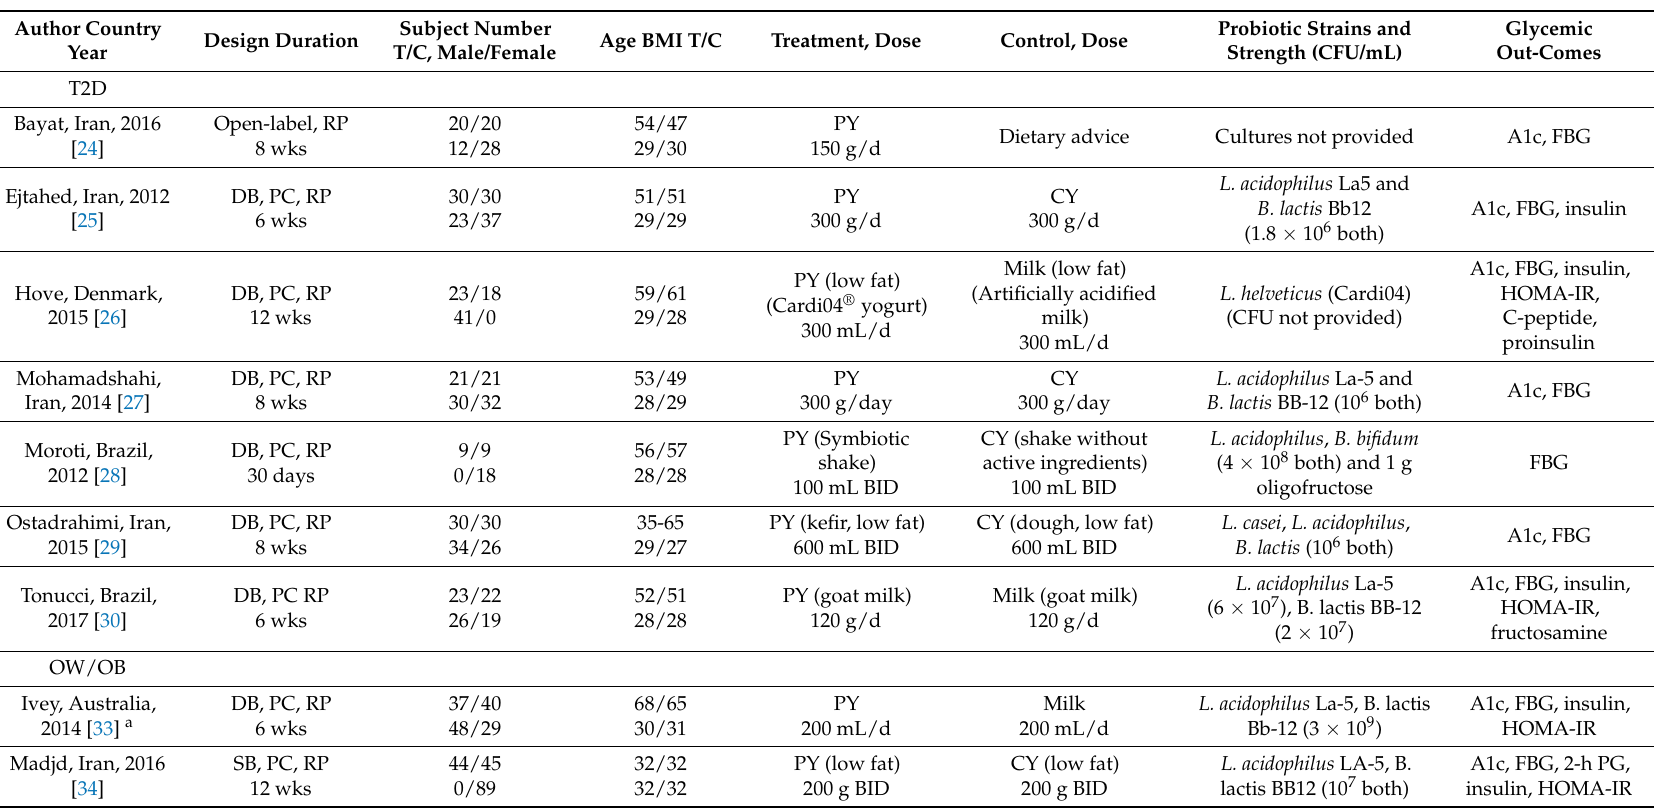
Table 1. Characteristics of included trials and data for participants at